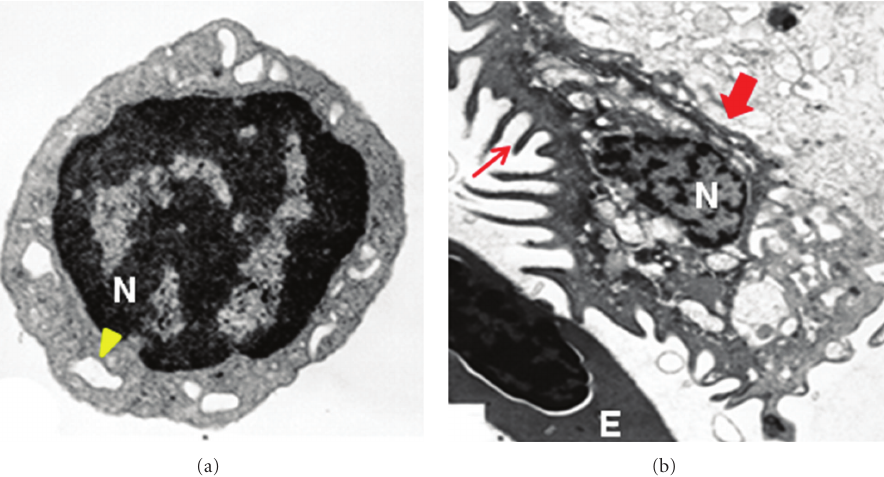
Figure 1: Zebrafish thrombocyte electron micrographs. (a) Zebrafish thrombocyte. Open canalicular like system is shown by arrowhead; N: nucleus; (b) An activated thrombocyte. Thrombocyte in an aggregation reaction; activated thrombocyte is shown by a thick arrow, thrombocyte in the aggregate shows filopodia shown by a thin arrow; E: erythrocyte [12].